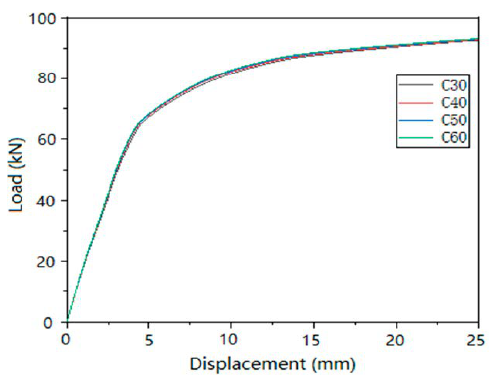
Figure 21. Load–displacement curves of the wallboard under different transverse spacing. Table 8. Ultimate load of concrete connectors of different strength grades.